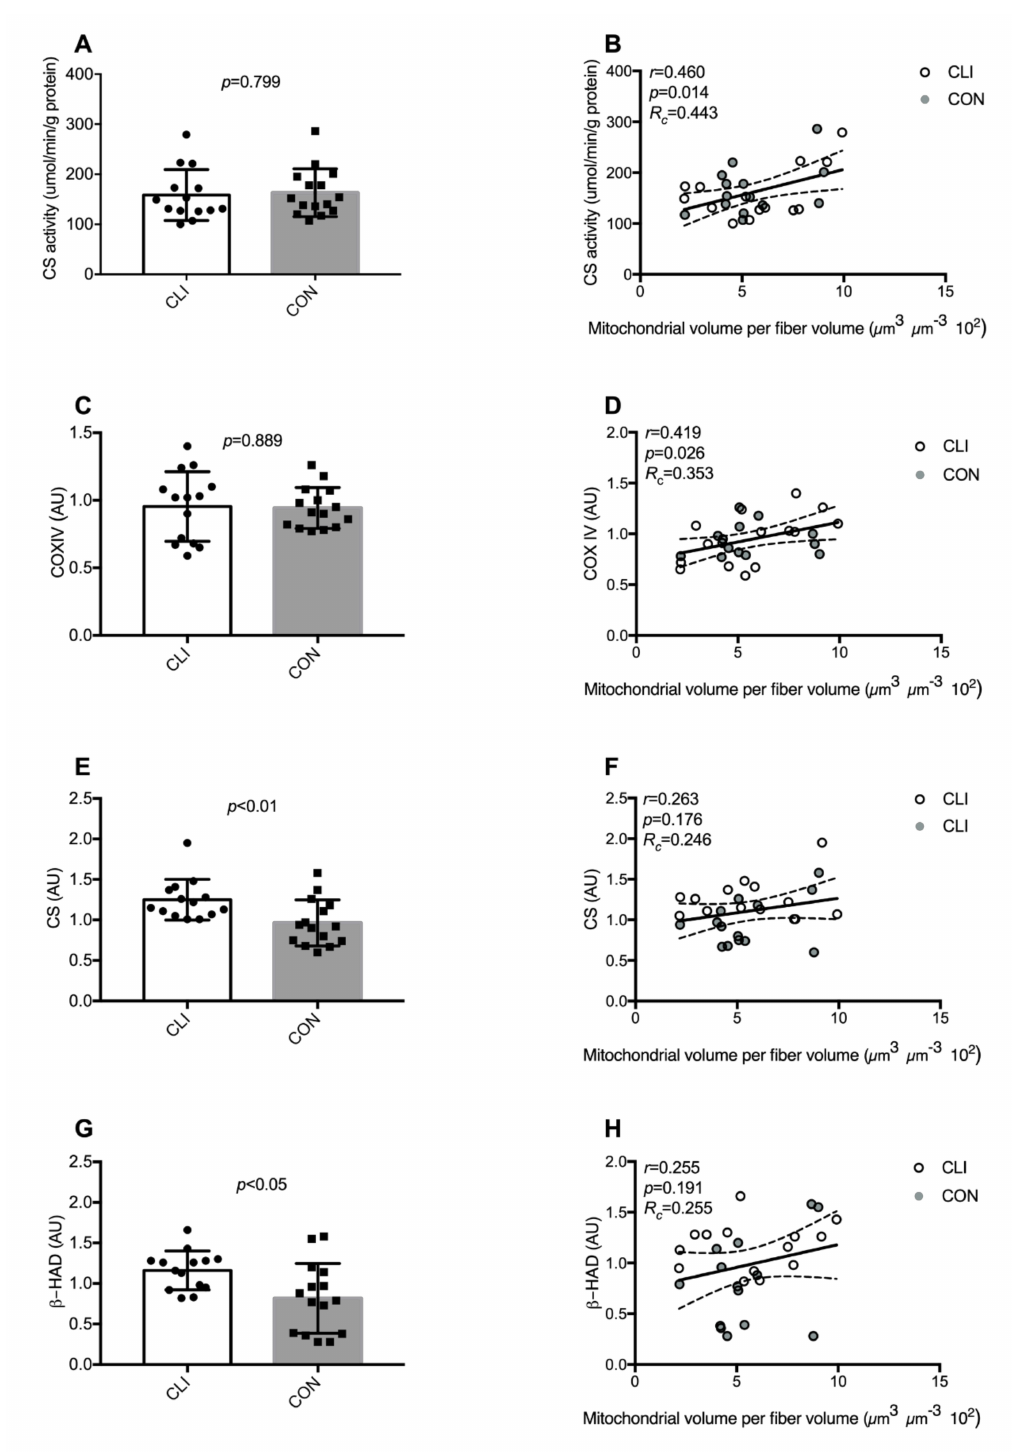
Figure 5. Markers of mitochondrial content. ( A ) Citrate synthase (CS) activity, ( C ) expression of cytochrome c oxidase subunit IV (COXIV), ( E ) CS, and ( G ) 3-hydroxyacyl-CoA dehydrogenase ( β -HAD) for CLI (n = 14) and CON (n = 15). Data are presented as means ± SD. Association between ( B ) CS activity, ( D ) COXIV protein expression, ( F ) CS protein expression, ( H ) β -HAD protein expression and mitochondrial volumetric content for all patients pooled (CLI (n = 14) and CON (n = 14)). Data are presented as individual values with line of fit (95% CI). Pearson’s correlation coe ffi cient (r), significance (p), and Lin’s coe ffi cient of concordance ( R c ) are designated in the upper left corners of the